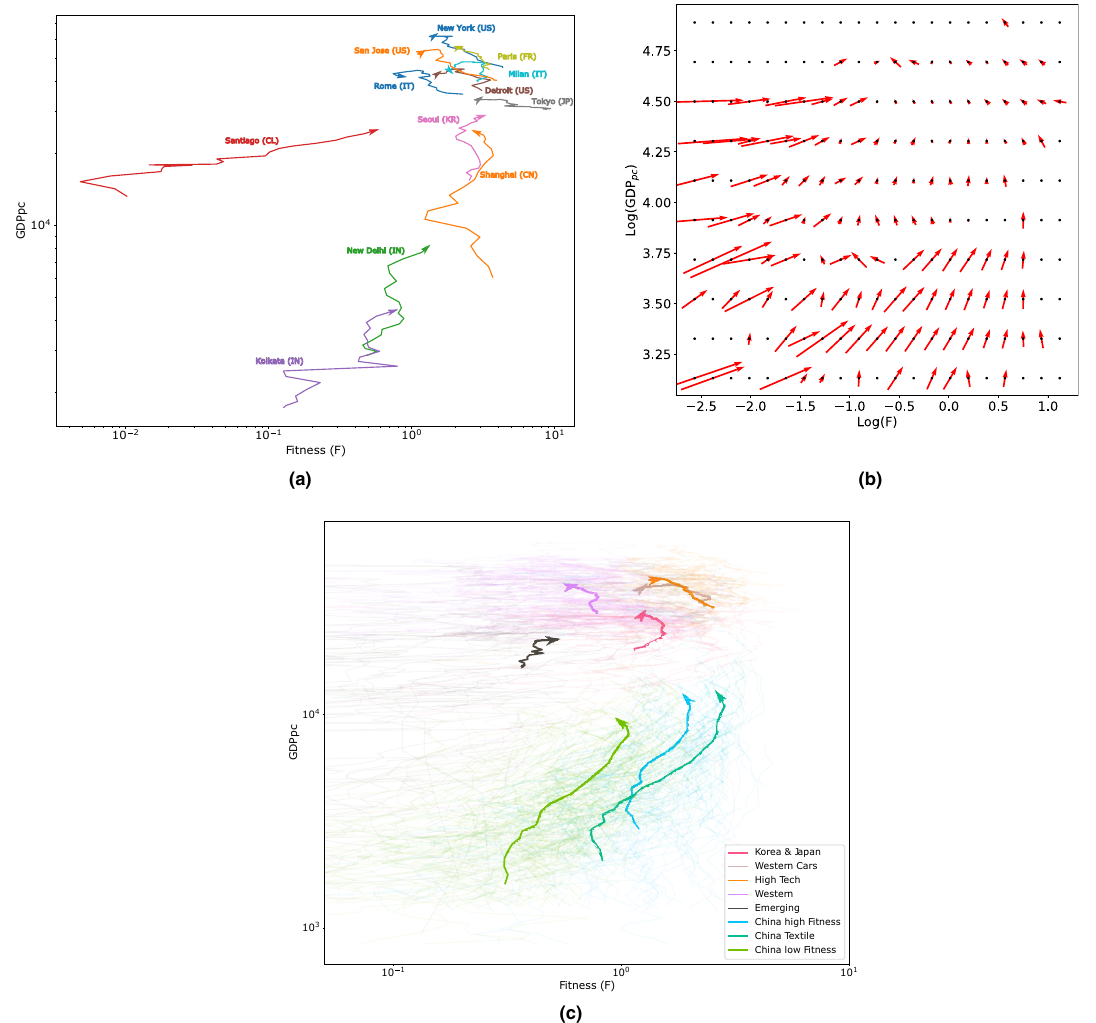
Figure 3. The Fitness-GDPpc plane in the case of metropolitan areas and their technological production. (a) We trace the trajectory of some MAs from 1990 to 2010 in the Fitness-GDPpc plane. MAs with high Fitness show a more significant increase in GDPpc. ( b ) We show an average vector field of the trajectories from 1995 to 2005. In this plot, we can better visualise how high Fitness is correlated to increases in GDPpc, most notably in the lower right part of the plot. In contrast, MAs with low Fitness will tend to increase it first. (c) Trends of all MAs, with trajectories coloured according to the community of belonging. For each community, we highlighted the average